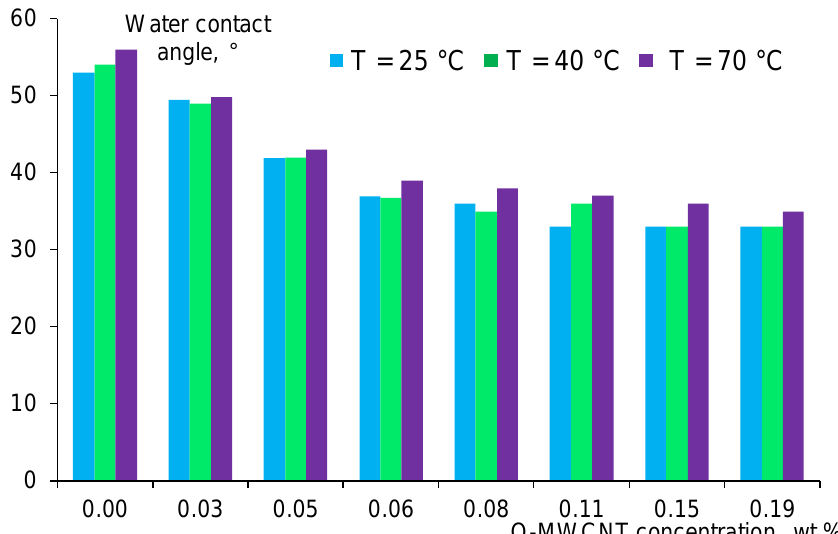
Figure 9. Effect of O-MWCNTs concentration in the casting solution on the water contact angle of the PPSU and nanocomposite PPSU/O-MWCNT membranes prepared at different coagulation bath temperatures: blue color—T cb = 25 °C; green color—T cb = 40 °C and violet color—T cb = 70 °C.